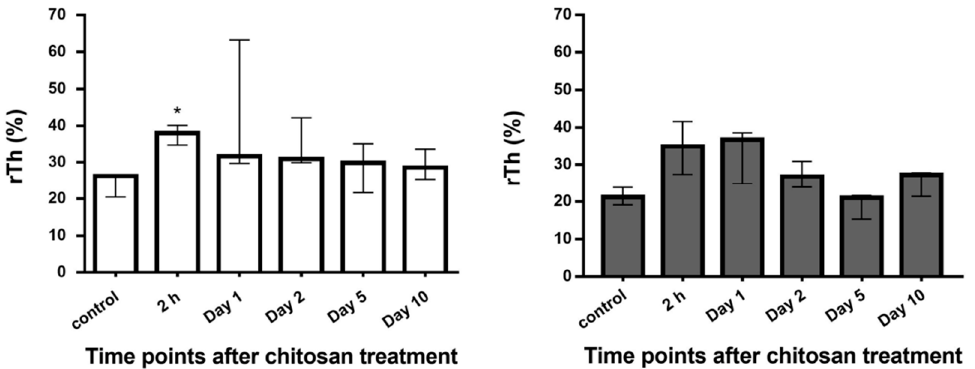
Figure 9. The relative thickness of lamina propria (rTh) in the urinary bladder wall of young mice (white columns) is significantly enlarged 2 h after chitosan treatment, while the increase is not significant in old mice (grey columns). Three tissue sections from one animal per each time point. Median ± interquartile range (IQR). * p < 0.05.